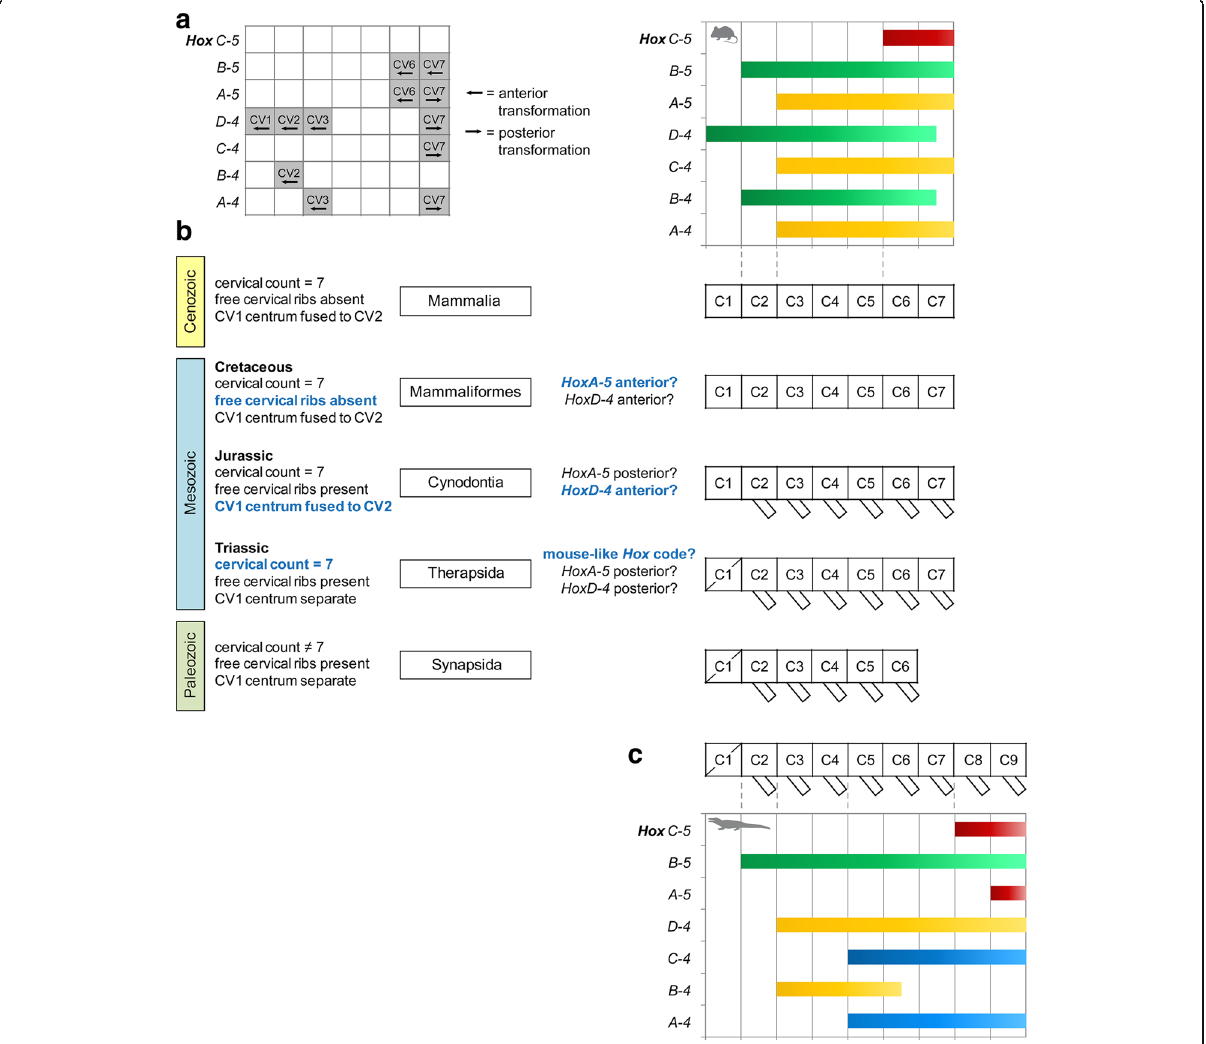
Fig. 3 Hox code and vertebral morphology through deep time. a Effect of single loss-of-function mutations in Hox4 and Hox5 paralog group on the cervical vertebral column in the mouse. b Overview and schematic illustration of characteristic features in the cervical vertebral column during synapsid evolution. The correlation between somitic Hox gene expression pattern and morphological modularity in the neck of Mus musculus (top right) allows to hypothesize about the Hox code in fossil relatives on basis of major morphological changes. Major morphological and reconstructed genetic changes are indicated in blue. The mouse Hox code is based on references provided in Table 3. c The correlation between somitic Hox gene expression pattern and morphological modularity in the neck of the crocodile serves as outgroup configuration (based on [13]). The crocodilian Hox code is based on references [8, 9,